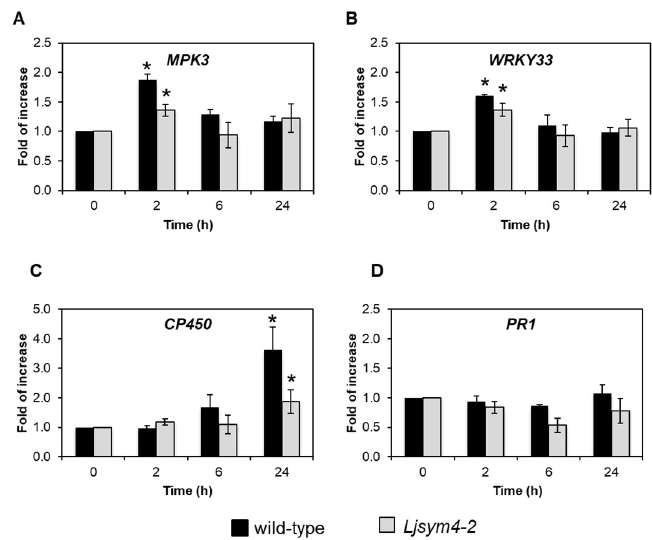
Figure 2. Analysis of HYTLO1-induced gene expression in L. japonicus cells. Semi-quantitative RT-PCR analysis of L. japonicus MPK3 ( A ), WRK33 ( B ), CP450 ( C ), and PR1 ( D ) in aequorin-expressing L. japonicus cell cultures of the wild-type line (black bars) and Ljsym4-2 mutant line (grey bars) in control conditions and after treatment with HYTLO1 (0.6 µM) for different time intervals. Data are the means ± SE of three independent experiments. * indicates statistically significant difference at P < 0.05.